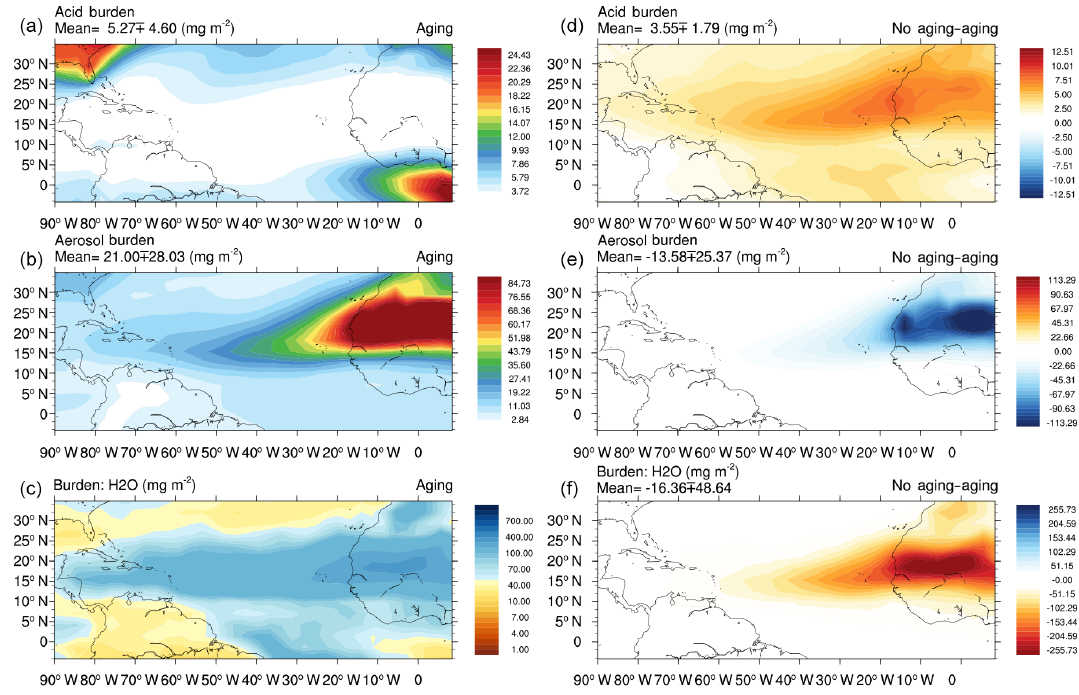
Figure 14. Monthly mean (July 2009) for the (top) burden of lumped inorganic gas-phase acids (HCl + HNO 3 + H 2 SO 4 ), the (middle) + HSO − + NO − + NH + + Cl − + Na + + Ca 2 + + K + + Mg 2 + ) and the (bottom) burden of the burden of lumped aerosols (SO 2 − 4 4 3 4 aerosol-associated water mass (monthly mean). The left column is a reference simulation (aging case), and the right column is the difference between the reference and the no aging case. Note the inverted color scales for the bottom two panels, where the higher aerosol water mass is shown in blue and the lower is shown in